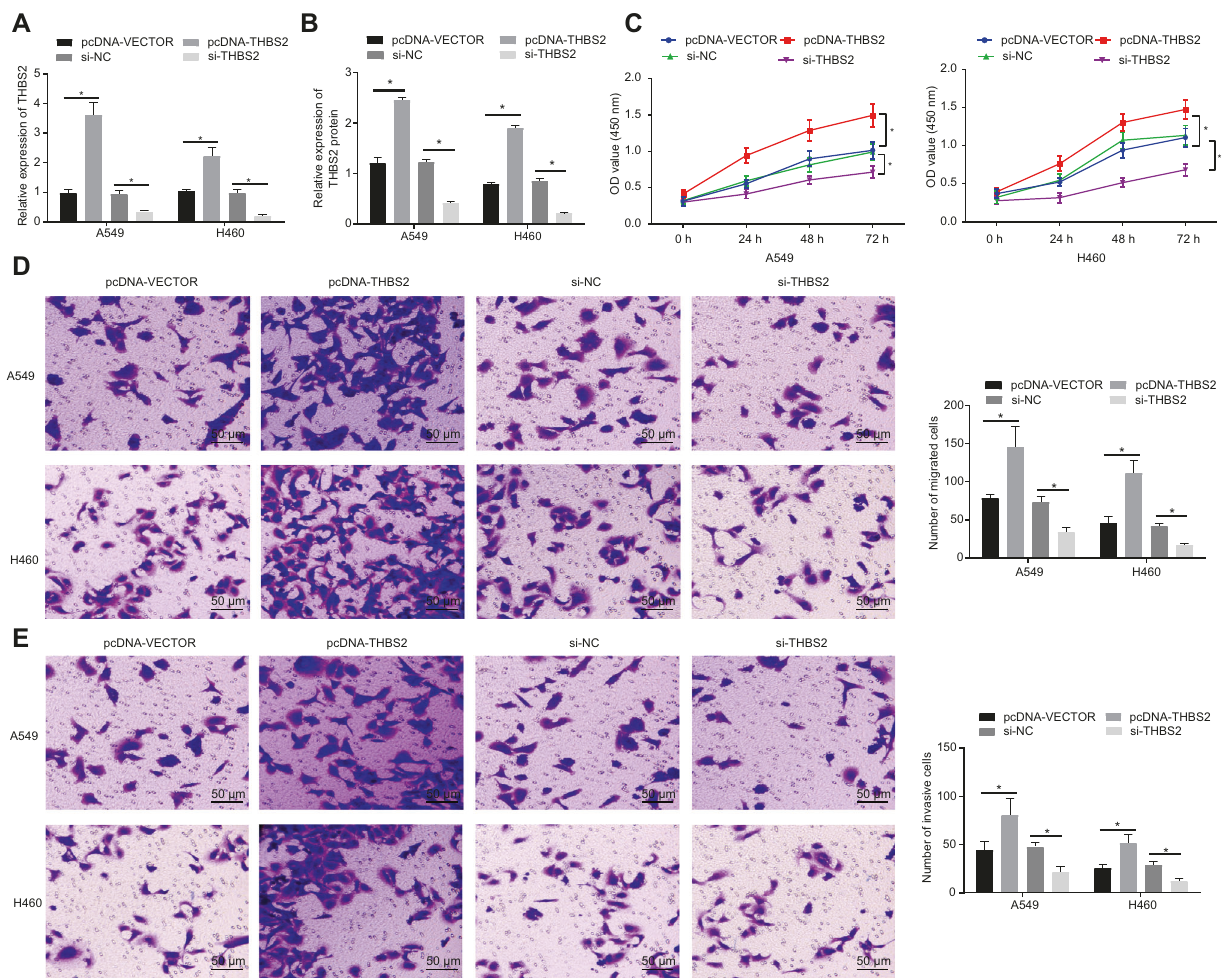
Fig. 6 Effects of THBS2 on the proliferation, migration, and invasion abilities of NSCLC cells. A THBS2 mRNA expression in A549 and H460 cells treated with pcDNA-THBS2 or si-THBS2 by RT-qPCR. B THBS2 protein level in A549 and H460 cells treated with pcDNA-THBS2 or si-THBS2 by Western blot analysis. C Proliferative ability of A549 and H460 cells treated with pcDNA-THBS2 or si-THBS2 detected by CCK-8 assay. D Migration ability of A549 and H460 cells treated with pcDNA-THBS2 or si-THBS2 detected by Transwell assay. E Invasive ability of A549 and H460 cells treated with pcDNA-THBS2 or si-THBS2 detected by Transwell assay. * p < 0.05 between two groups. Data among multiple groups were compared by ANOVA with Tukey ’ s post hoc test. Comparisons among groups at different time points were performed using repeated measures ANOVA with Bonferroni ’ s post hoc test. Cell experiments were repeated three the lungs of these mice compared with untreated mice, while this decline could be reversed by simultaneously overexpressing THBS2 (Fig. 8F – H). In addition, Western blot analysis suggested that MSCs- EVs suppressed the expression of Vimentin and MMP-9 and enhanced the expression of E-cadherin in the metastases, which were reversed by overexpressing THBS2 (Fig. 8I). In summary, these in vivo experiments also veri fi ed that MSCs-EVs transferred miR-598 to inhibit the growth and metastasis of NSCLC in vivo by down- regulating THBS2 expression.